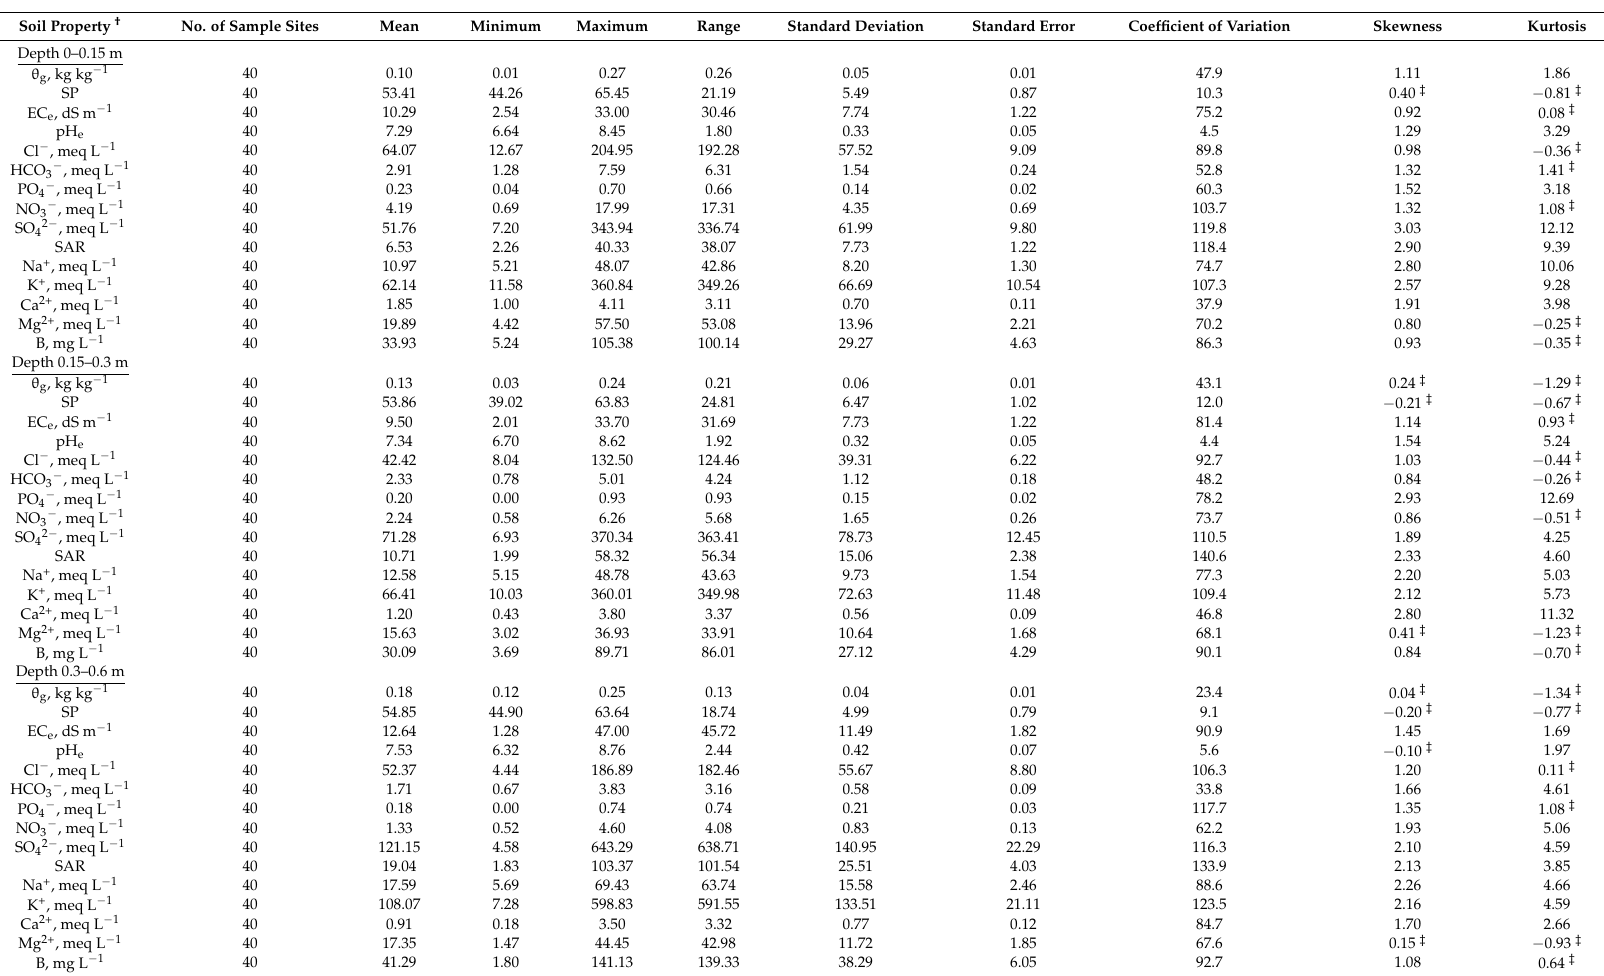
Table 1. Mean and range statistics of soil edaphic properties for the depths within the root zone of 0–0.15, 0.15–0.3, 0.3–0.6, 0.6–0.9, 0.9–1.2, and 1.2–1.5 m of the combined full-field (20 soil sample locations) and southeast-corner (20 soil sample locations)